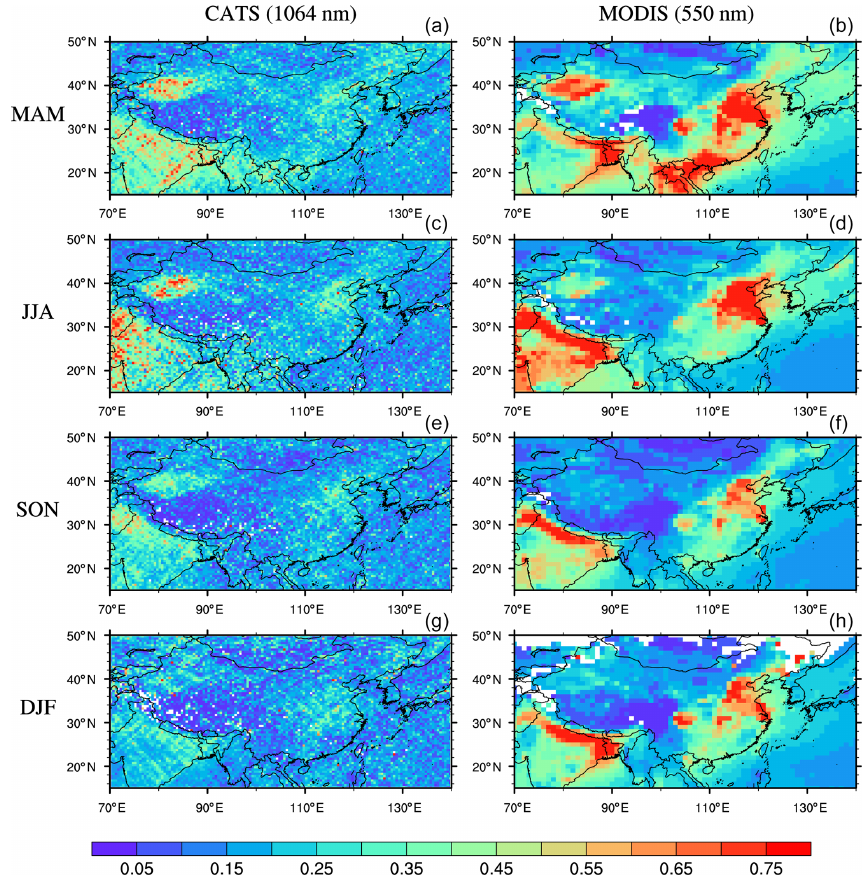
Figure 2. Seasonally averaged AOT distributions from CATS at 1064nm and MODIS at 550nm for 2015–2017: (a, b) spring (MAM); (c, d) summer (JJA); (e, f) fall (SON); and (g, h) winter